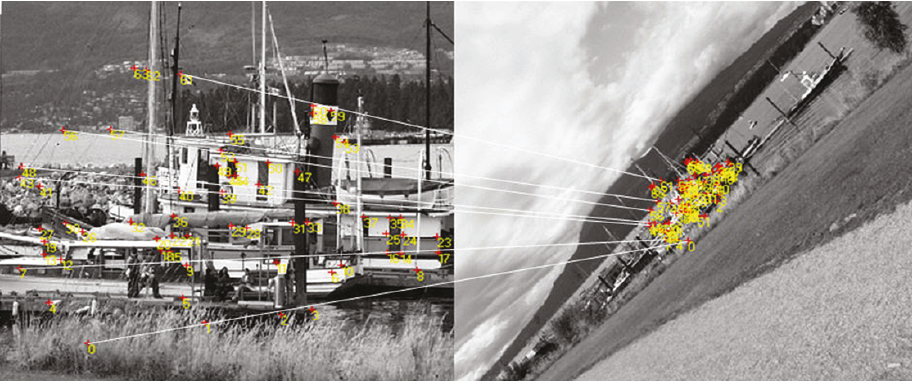
Figure 10: Matching result for image pair Boat (frames 0 and 9 of “Boat” sequence). The scale factor is 4.3, and the rotation angle is 45